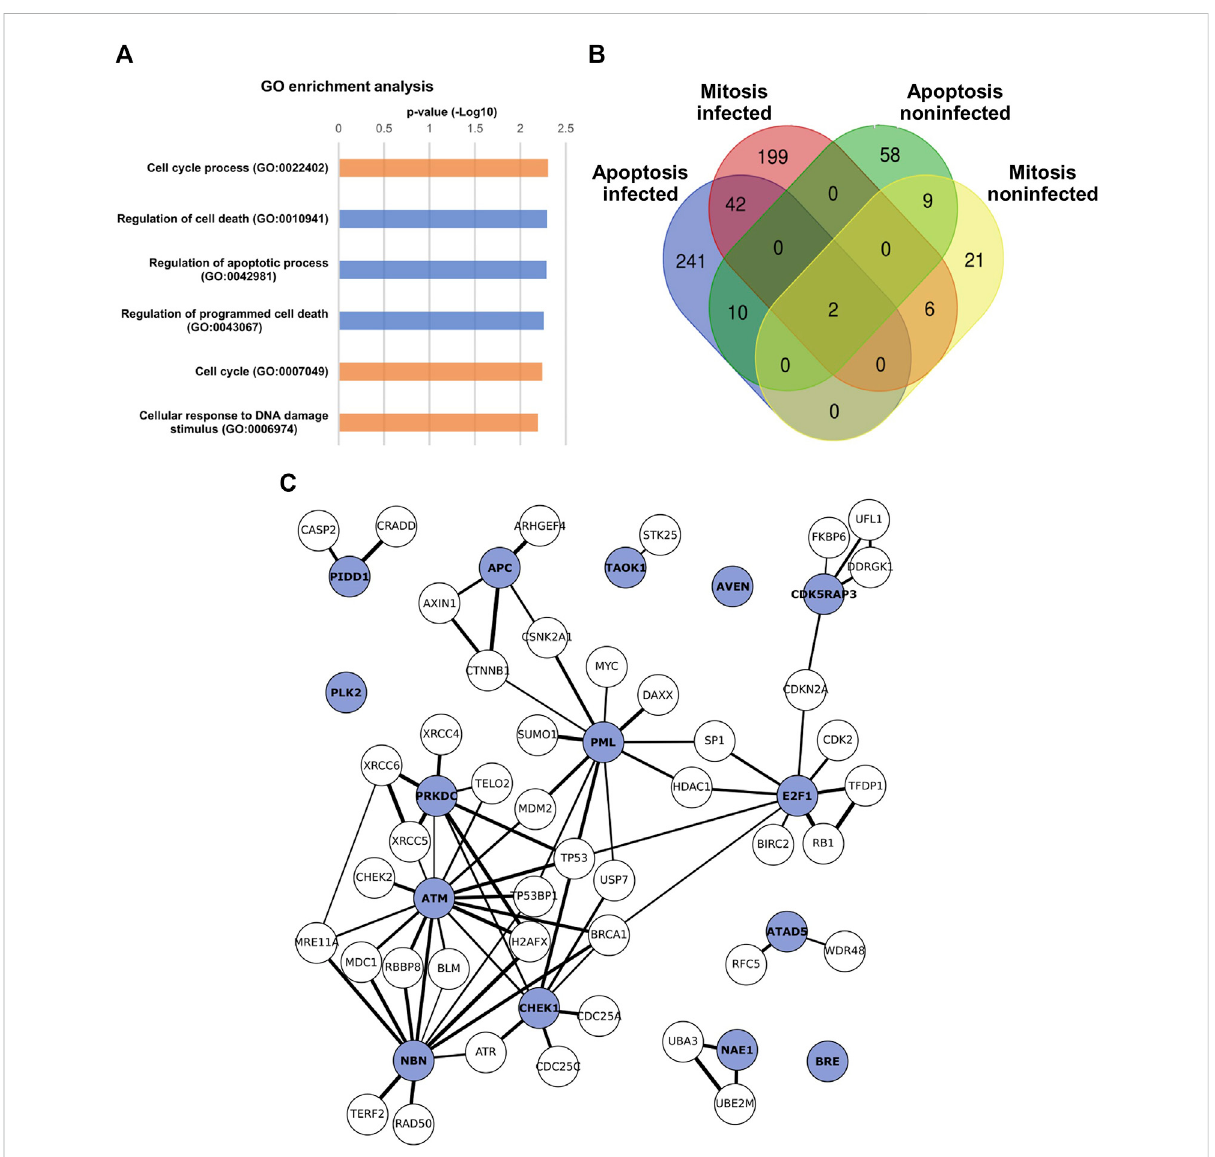
FIGURE 9 Infection leads to H3K27 acetylation and deacetylation of host genes associated with mitotic and apoptotic events ChIP-seq analysis of H3K27ac acetylation in non-infected and infected NLFK cells at 24 hpi. (A) Cell cycle and apoptosis-related GO terms in infected cells detected by H3K27Ac enrichment analysis. Bar charts of the p - v alues (-log10) for the differentially acetylated GO categories with acetylation loss (blue) and acetylation gain (orange) between non-infected and infected samples. False discovery rate < 0.05 was used as a threshold to enroll signi fi cantly enriched GO categories. (B) A Venn diagram representing the number of genes with H3K27ac enrichment in regions surrounding the transcription start sitesassociated with mitosis and apoptosis, andtheir overlap ininfected andnon-infected cells. Genesrelated to mitosis were pooled fromGO classes: regulation of mitotic cell cycle (GO:0007346), mitotic cell cycle (GO:0000278), mitotic cell cycle process (GO:1903047), and regulation of mitotic cell cycle phase transition (GO:1901990). Genes involved in apoptosis were negative in the regulation of the apoptotic process